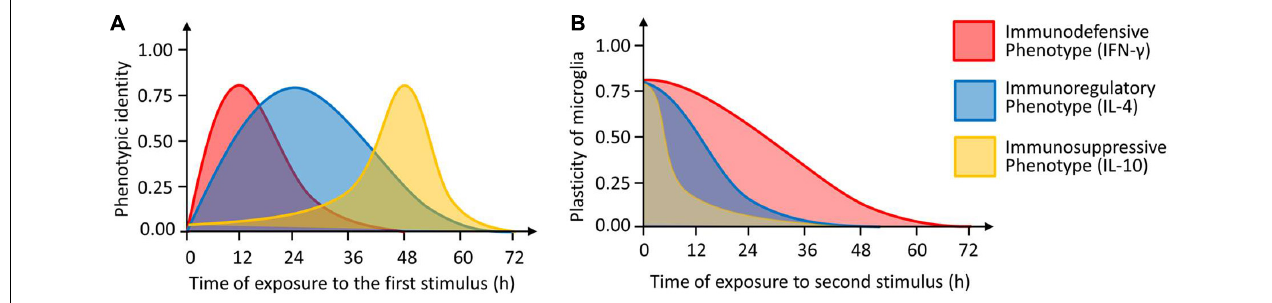
FIGURE 13 | The identity and plasticity of microglial phenotype. (A) Timing of induction of three microglial phenotypes (immunodefensive phenotype induced by IFN- γ , immunoregulatory phenotype induced by IL-4 and immunosuppressive phenotype induced by IL-10). The “1.0” means that the cells show the maximal identify. (B) Plasticity of microglial phenotypes as a function of the length of second stimulation. The “1.0” means that the cells show the maximal